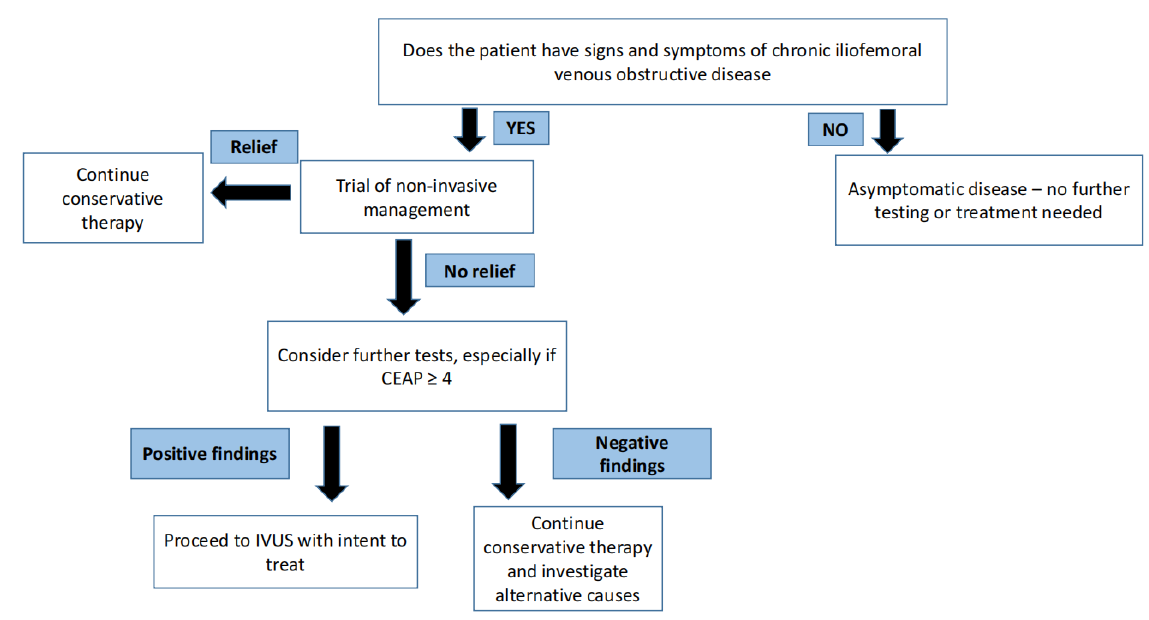
Figure 2. Philosophy of treating symptomatic and asymptomatic chronic venous disease.